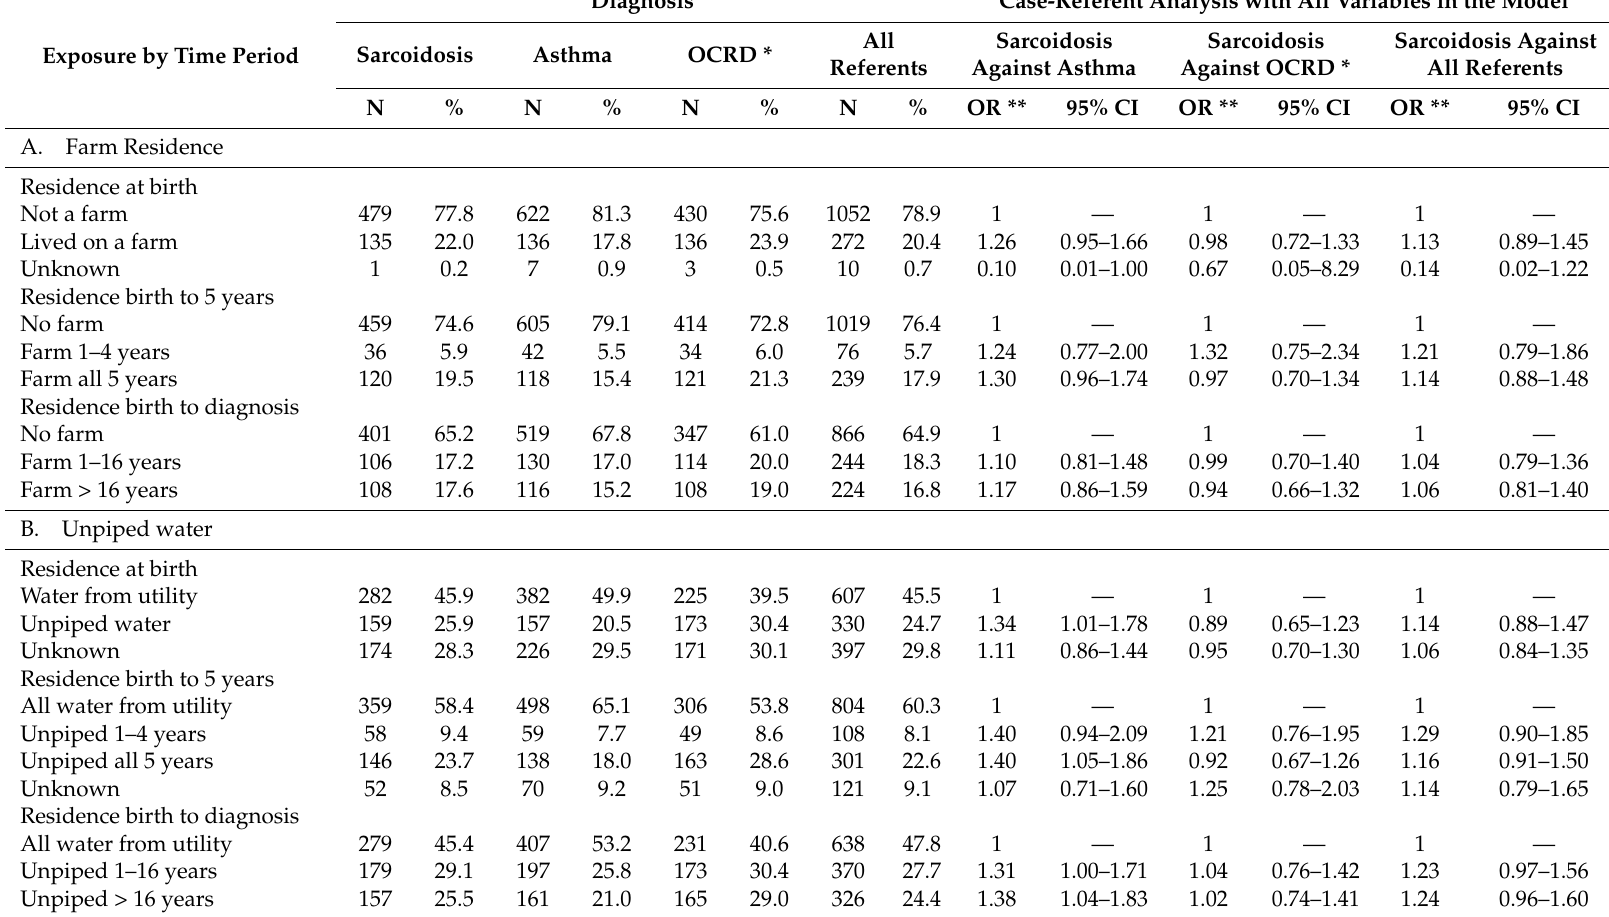
Table 2. Farm residence, use of unpiped water and farm milk in three periods by diagnosis: tabulation and multivariable logistic regression models comparing cases of sarcoidosis against referent